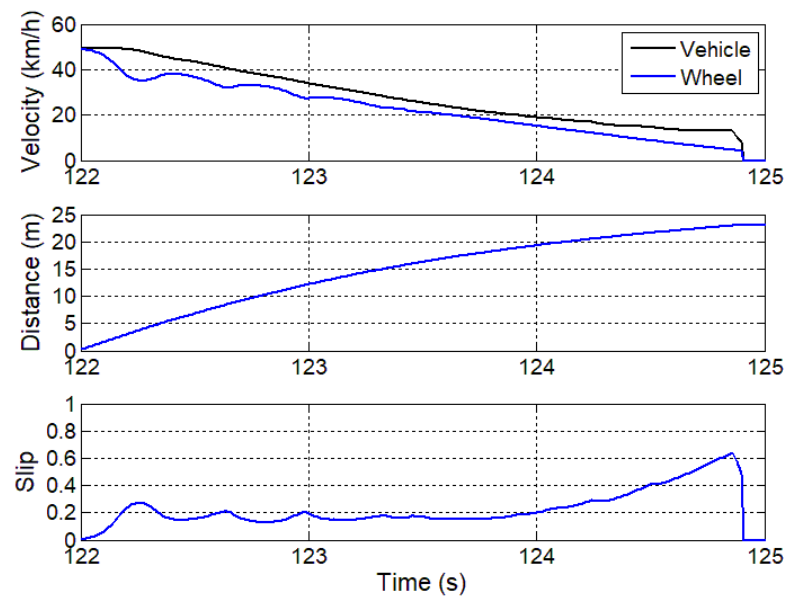
Figure 9. ABS variables measured by developed test bench.